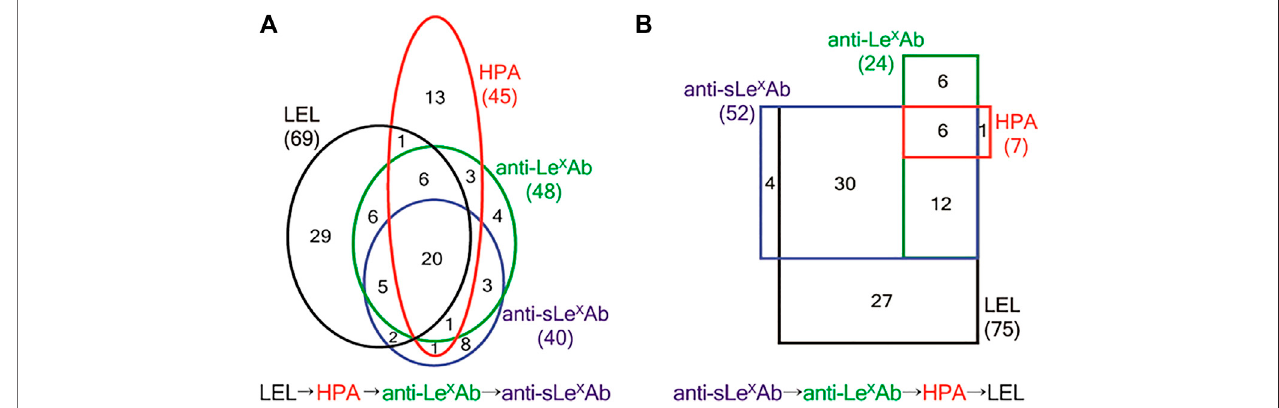
FIGURE 2 | (A) Number of proteins identi fi ed from LEL → HPA → anti-LexAb → anti-sLexAb SAC. Numbers in the black, red, green, and blue ovals show the proteinsidenti fi edfromLEL,HPA,anti-LexAb,andanti-sLexAbcolumns,respectively.Atotalof102proteinswereidenti fi ed. (B) Numbersofproteinsidenti fi edfromanti- sLexAb → anti-LexAb → HPA → LEL SAC. Numbers in the black, red, green, and blue rectangles show the proteins identi fi ed from LEL, HPA, anti-LexAb, and anti- sLexAb columns, respectively. A total of 86 proteins were identi fi ed. LEL: Lycopersicon esculentum lectin. HPA: Helix pomatia lectin. anti-LexAb: Anti-Lewis x antibody. anti-sLexAb: anti sialyl Lewis x antibody. SAC: serial af fi nity chromatography. Reprinted with permission from Jung, K., and Cho, Anal. Chem. 2013, 85, 7,125 – 7,132, Copyright © 2013, American Chemical Society.